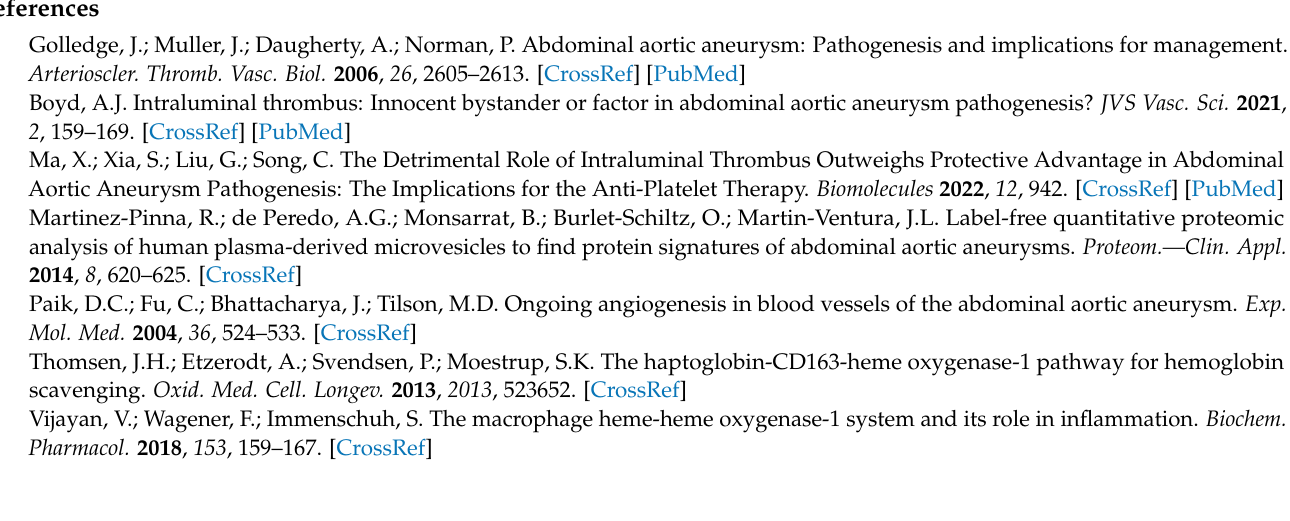
AAA and controls. Table S1: Primersequences; Table S2: Plasma sCD163, cardiovascular risk factors and medical therapy in AAA patients; Table S3: Serum bilirubin concentrations, cardiovascular risk factors and medical treatment in AAA; Table S4: Serum bilirubin concentrations and associations with the AAA